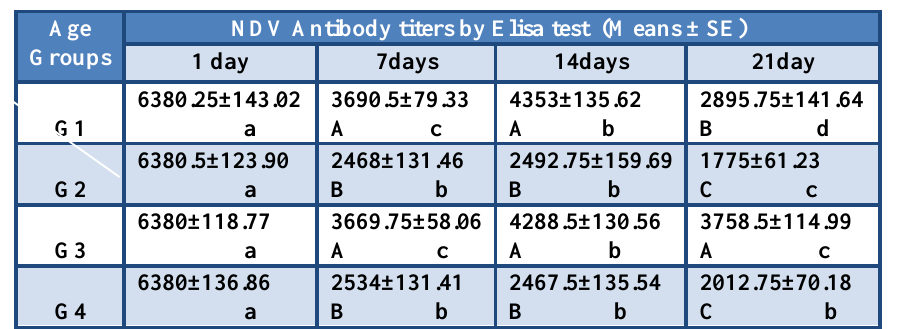
Table,1: Effect of 225µg/ml of soluble β- glucan supplementation in drinking water on antibody response of heat stressed and non heat stressed broiler chickens groups to NDV vaccine. Antibody titer to NDV